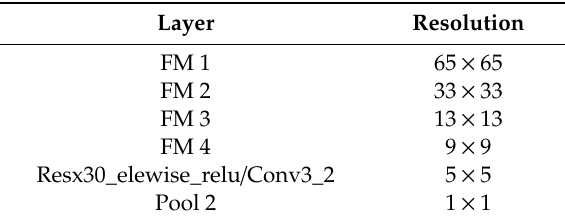
Table 4. The resolution of each feature maps used for prediction.